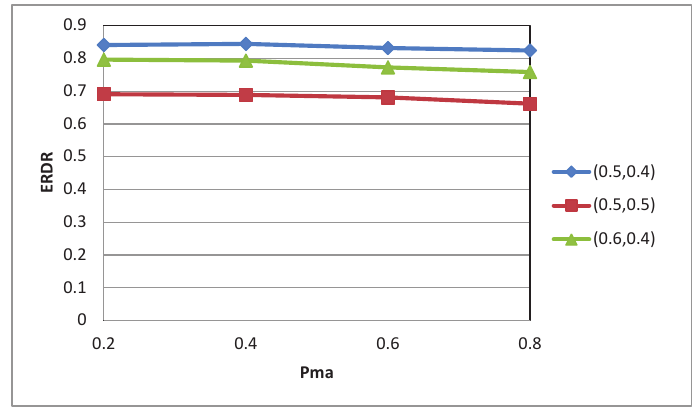
= r , when r . ma e c